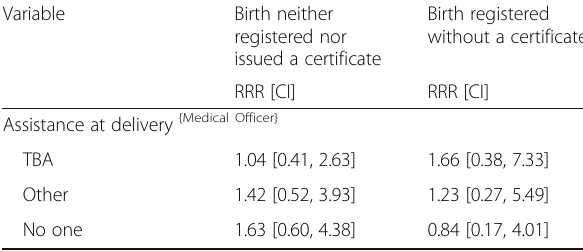
Table 3 Predictors of child registration